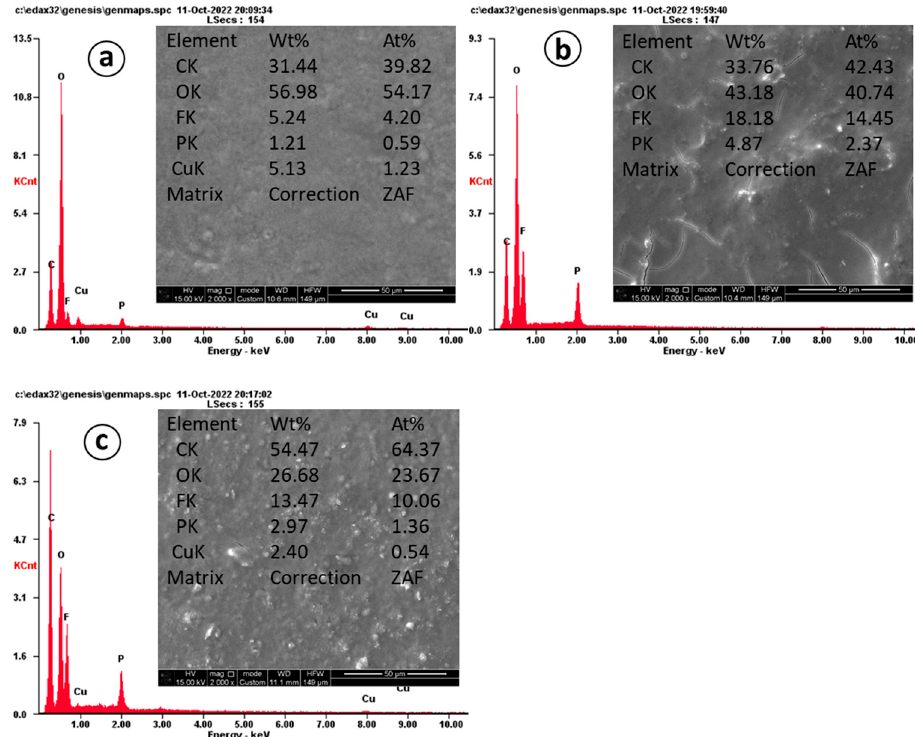
Figure 8. EDX and SEM images of CNF electrodes after 600 cycles: ( a ) 800 °C, ( b ) 900 °C, ( c ) 1000